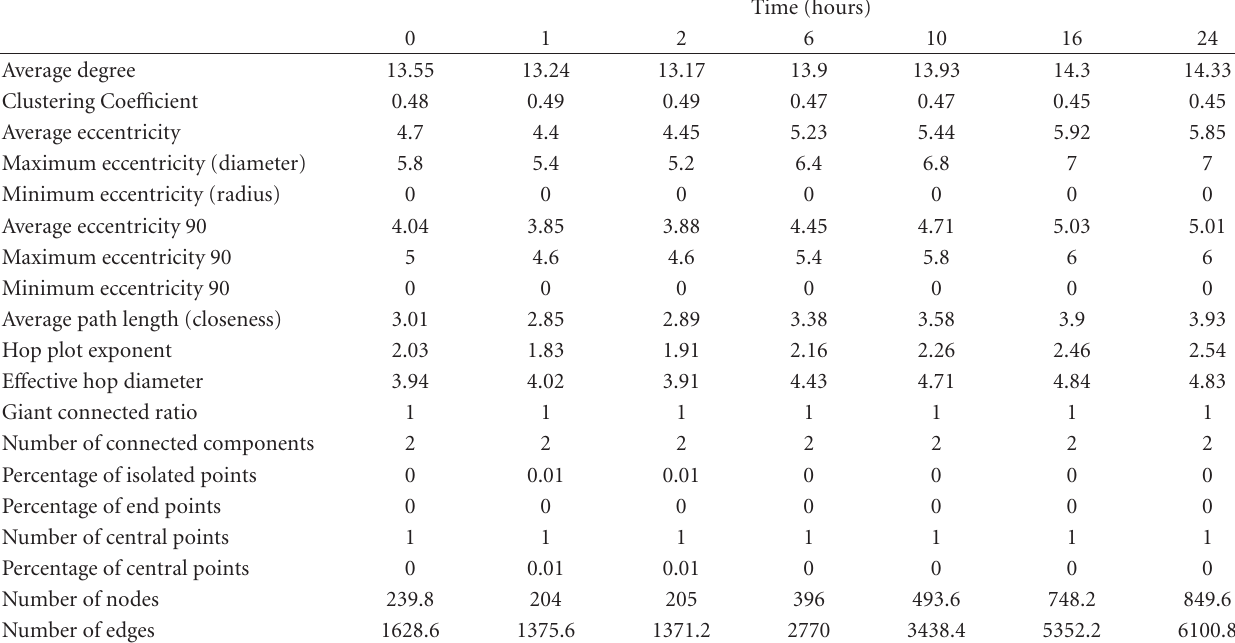
Table 6: Quantitative delaunay graph metrics for 1 × 10 6 cells/mL collagen I hydrogel 24-hour timecourse.